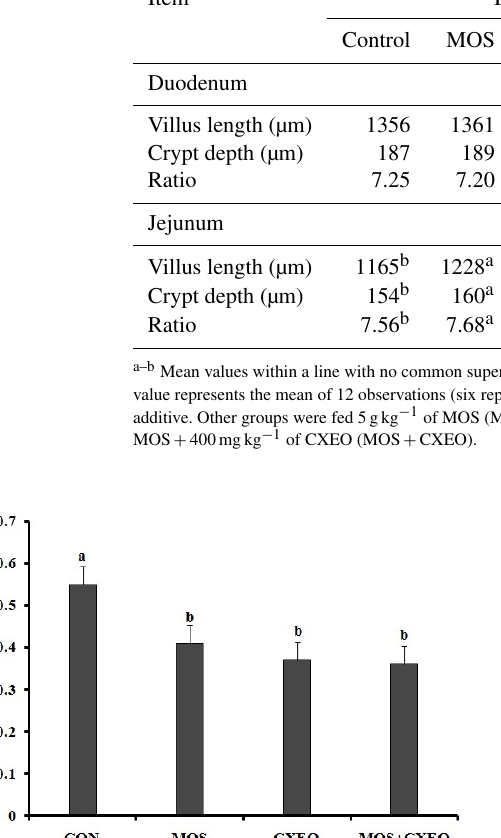
Figure 1. Effect of mannan oligosaccharide (MOS) and Curcuma xanthorrhiza essential oil (CXEO) on creatine kinase (expressed as Umg − 1 of protein) level of chicken breast muscle. Mean val- ues represent the average of 12 observations (six replicates × two birds / replicate). Values are means ± SEM. Within the graph, bars with different letters (a, b) are significantly different ( P<